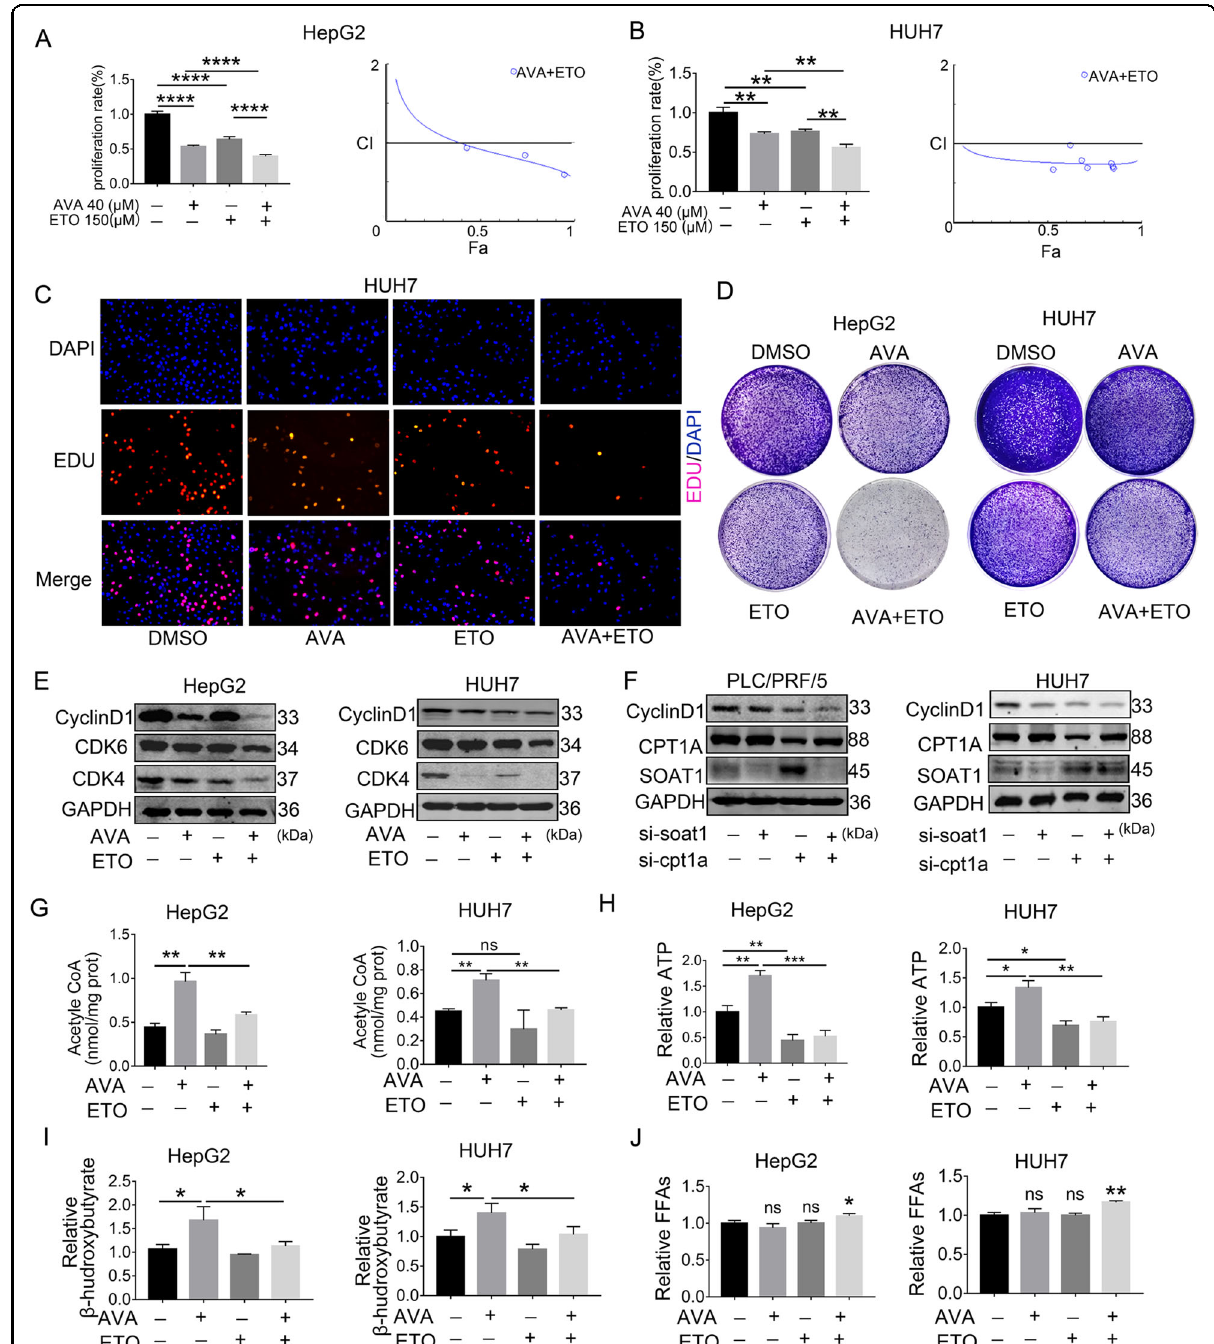
Fig. 7 Combined avasimibe and etomoxir enhance the ef fi cacy by disrupting lipid homeostasis in HCC in vitro. A – B CCK8 assay showed that combined avasimibe and etomoxir enhanced the ef fi cacy in the HepG2 and HUH7 (means± SEM, n = 3). Chou and Talalay analyzed the combination indices (CI) of combined AVA and ETO for 48 h in HepG2 and HUH7. The straight line at CI = 1 represents the additive effects of both drugs. Fraction effect (FA): growth inhibition rate. C Representative images of the EdU staining assay in HUH7 cells treated with AVA, ETO, or both. D The colony formation assay of HepG2 and HUH7 cells cultured with 2 μ M AVA and/or 25 μ M ETO for 14 days. E Western blot analysis of CDK4, CDK6, and Cyclin D1 in HepG2 and HUH7 cells treated with 20 μ M AVA and/or 150 μ M ETO. F Western blot analysis of CyclinD1, CPT1A, and SOAT1 after transfection with si-SOAT1and/or si-CPT1A in PLC/PCF/5 and HUH7. G – I Levels of total acetyl-CoA, ATP and β -hydroxybutyrate in HCC cells treated with AVA (5 μ M) and/or ETO (50 μ M) (mean± SEM, n = 3); * p < 0.05, ** p < 0.01, *** p < 0.001; ns: no signi fi cance. J Levels of intrahepatic FFAs in HepG2 and HUH7 treated with AVA (5 μ M) and/or ETO (50 μ M) (mean ± SEM, n = 3); * p <